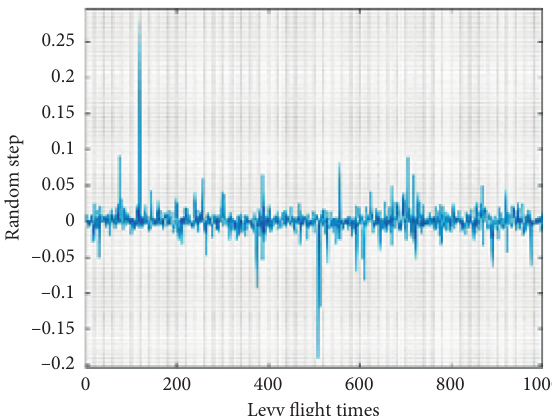
Figure 8: Random step distribution of Levy